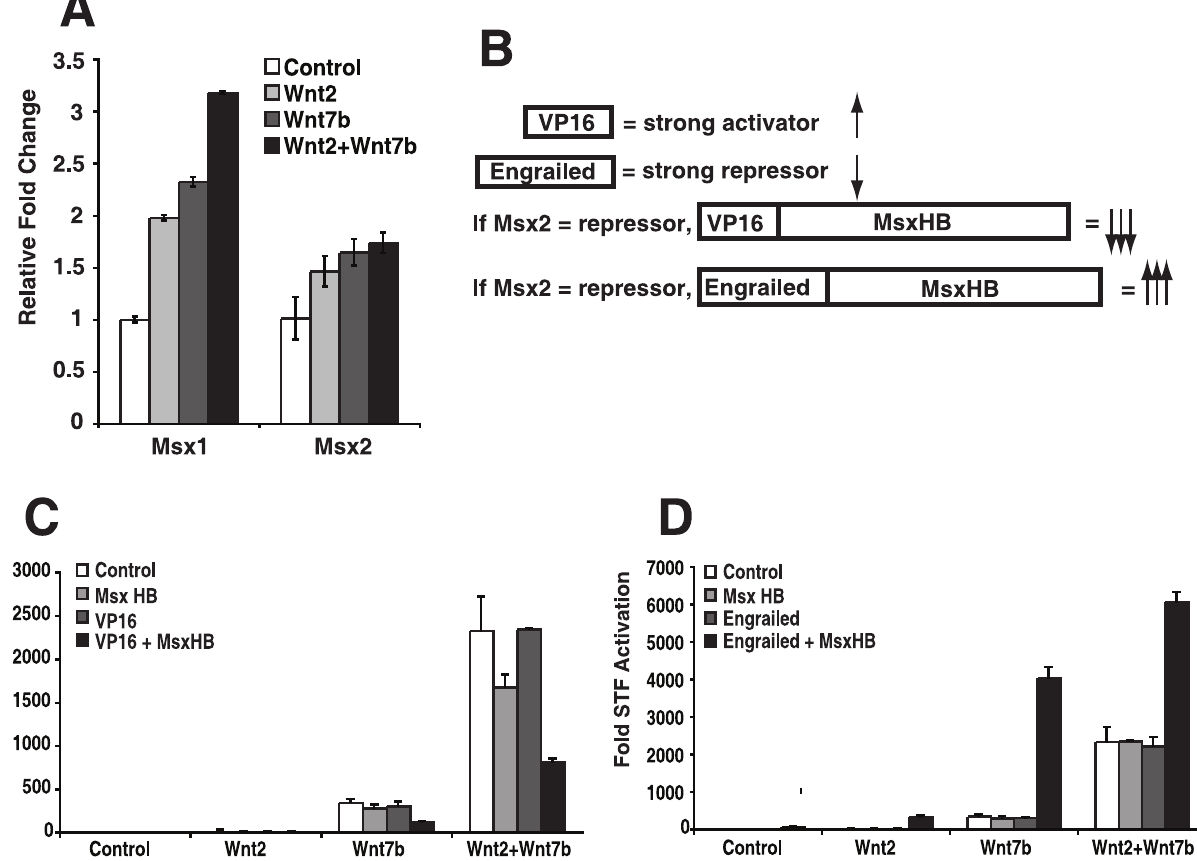
Figure 4. Msx1/2 expression is induced by Wnt2-Wnt7b and Msx represses gene transcription to promote Wnt2-Wnt7b cooperative signaling. Wnt2 and Wnt7b increase Msx1/2 gene expression in RFL6 cells (A). Diagram of Msx1 HB fusion proteins made with the VP16 activation domain and the engrailed repression domain (B). Expression of the MsxHB-VP16 fusion represses Wnt2-Wnt7b cooperative signaling (C), while expression of the MsxHB-engrailed fusion enhances Wnt2-Wnt7b cooperative signaling